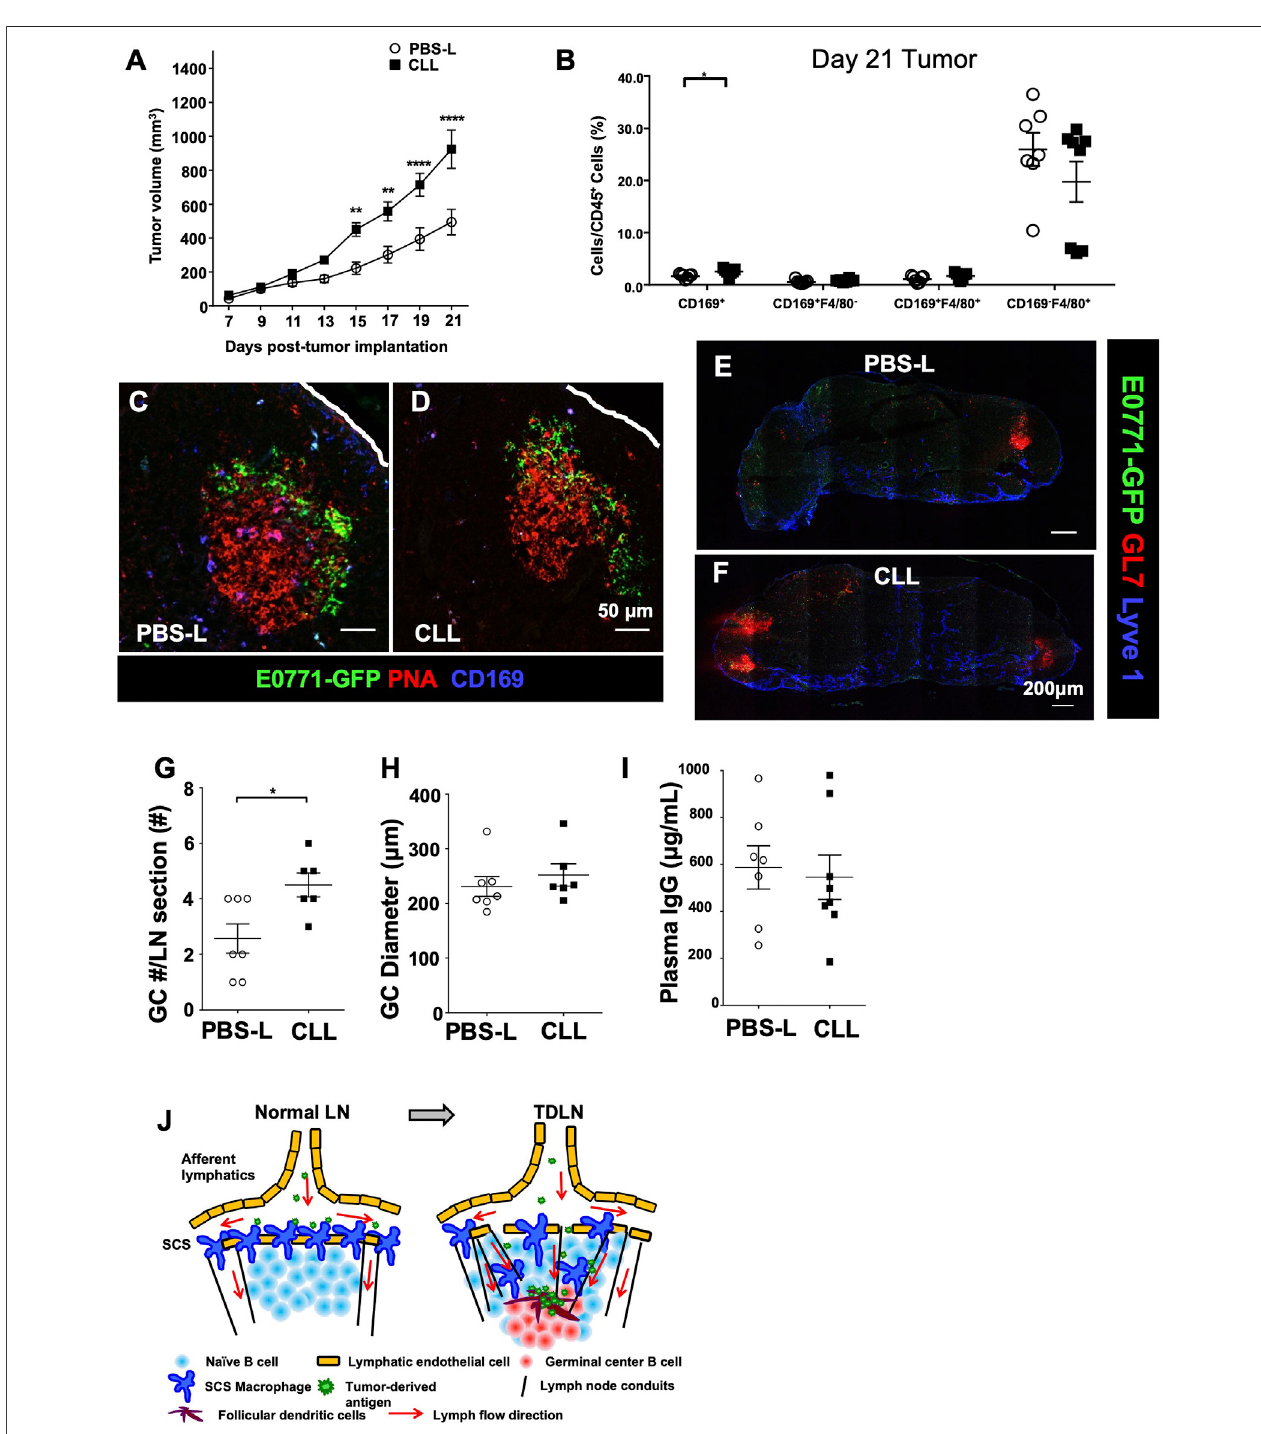
FIGURE 5 | Tumor growth reconstructs CD169 + SCS macrophages to promote tumor-derived antigen entry into GCs. (A) SCS macrophage depletion with CLL signi fi cantly increases E0771 tumor growth over 21 days ( n = 10 per group, in two separated experiments). Data is mean ± SEM. ** p < 0.01, **** p < 0.0001. Two-way ANOVA with Sidak ’ s multiple comparisons test. (B) Flow cytometry of E0771-GFP tumor macrophage populations demonstrates no depletion of tumor-associated macrophages from CLL treatment ( n = 5-6per group, in two separated experiments).Datais mean ±SEM. * p < 0.05. Unpaired, parametric student ’ s t -test. (C,D) GFP in GCs remains unchanged between control PBS-L and CLL-treated mice. Images are representativeof n = 5per group, in two separated experiments. (E – H) The numberofGCswasincreases perLNinCLL-treatedmice compared tocontrolPBS-L-treated mice,but diameteroftheGCsremainssimilar.Images arerepresentative of n =6-7pergroup,intwoseparatedexperiments. Dataismean±SEM.* p < 0.05.Mann-WhitneyUtest. (I) TheamountofplasmaIgGdidnotchangebetweenPBS-L